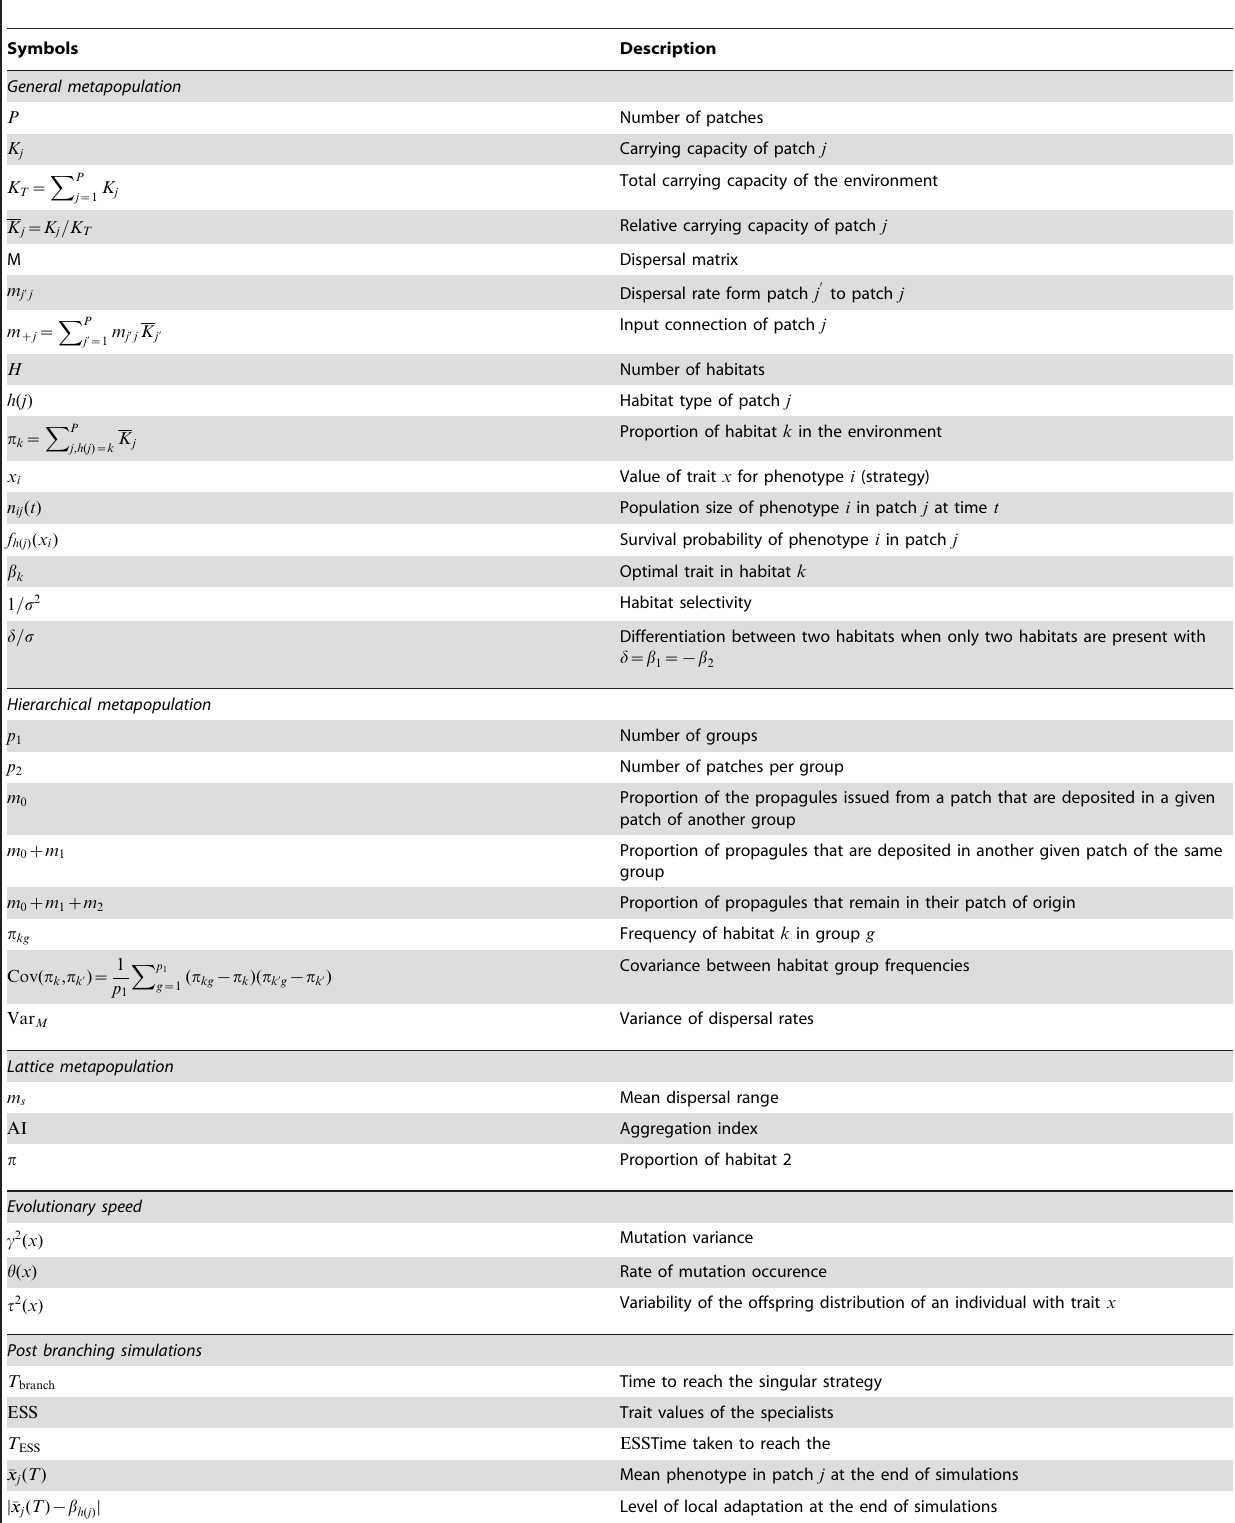
Table 1. Definition of the main notations.